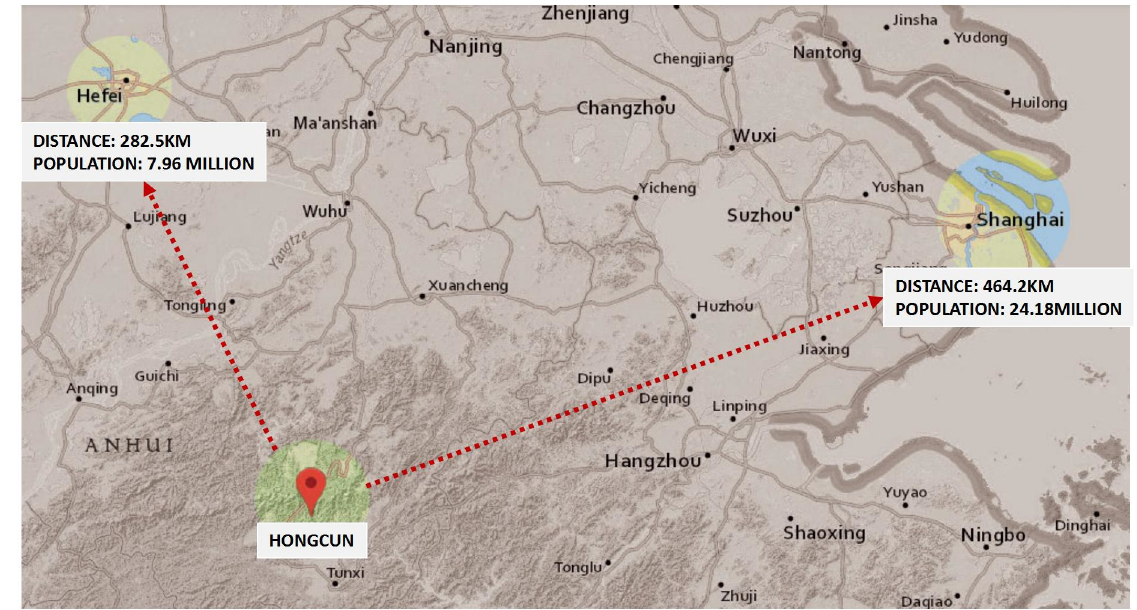
Fig 1. The site location of Hongcun and the distances to major cities. (The figure is obtained from the USGS National Map Viewer). Source: Annotated by